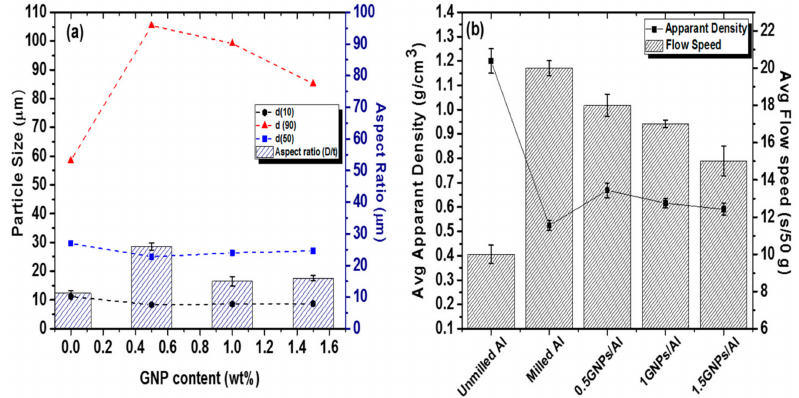
Figure 10. Particle size analysis and aspect ratio of the GNPs/Al composite powders after solution ball milling